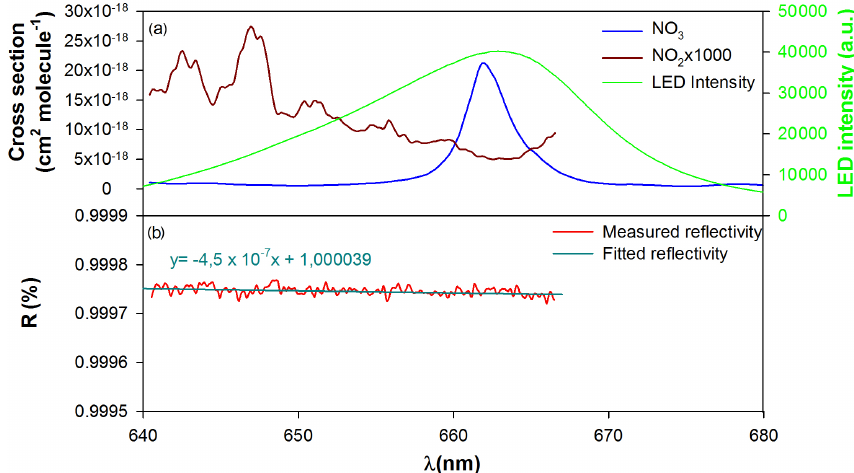
Figure 2. (a) NO 3 and NO 2 absorption cross sections (Orphal et al., 2003; Vandaele et al., 1997) between 640 and 680nm (convolved with apparatus function of the spectrometer) and LED emission spectrum and (b) mirror